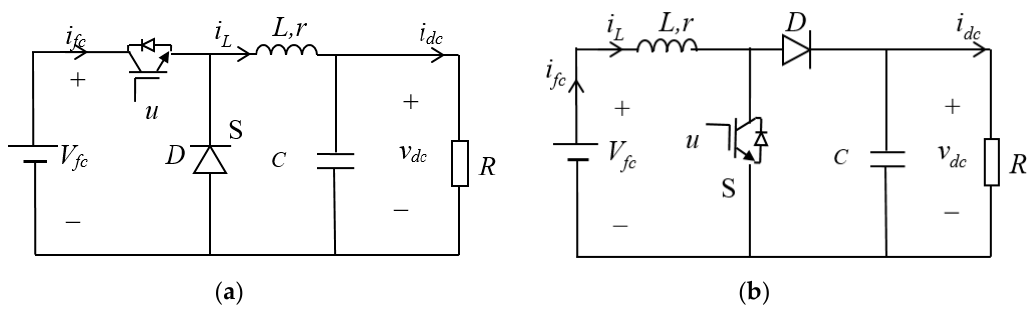
Figure 2. DC-DC buck and boost power converters. ( a ) Buck converter. ( b ) Boost converter.